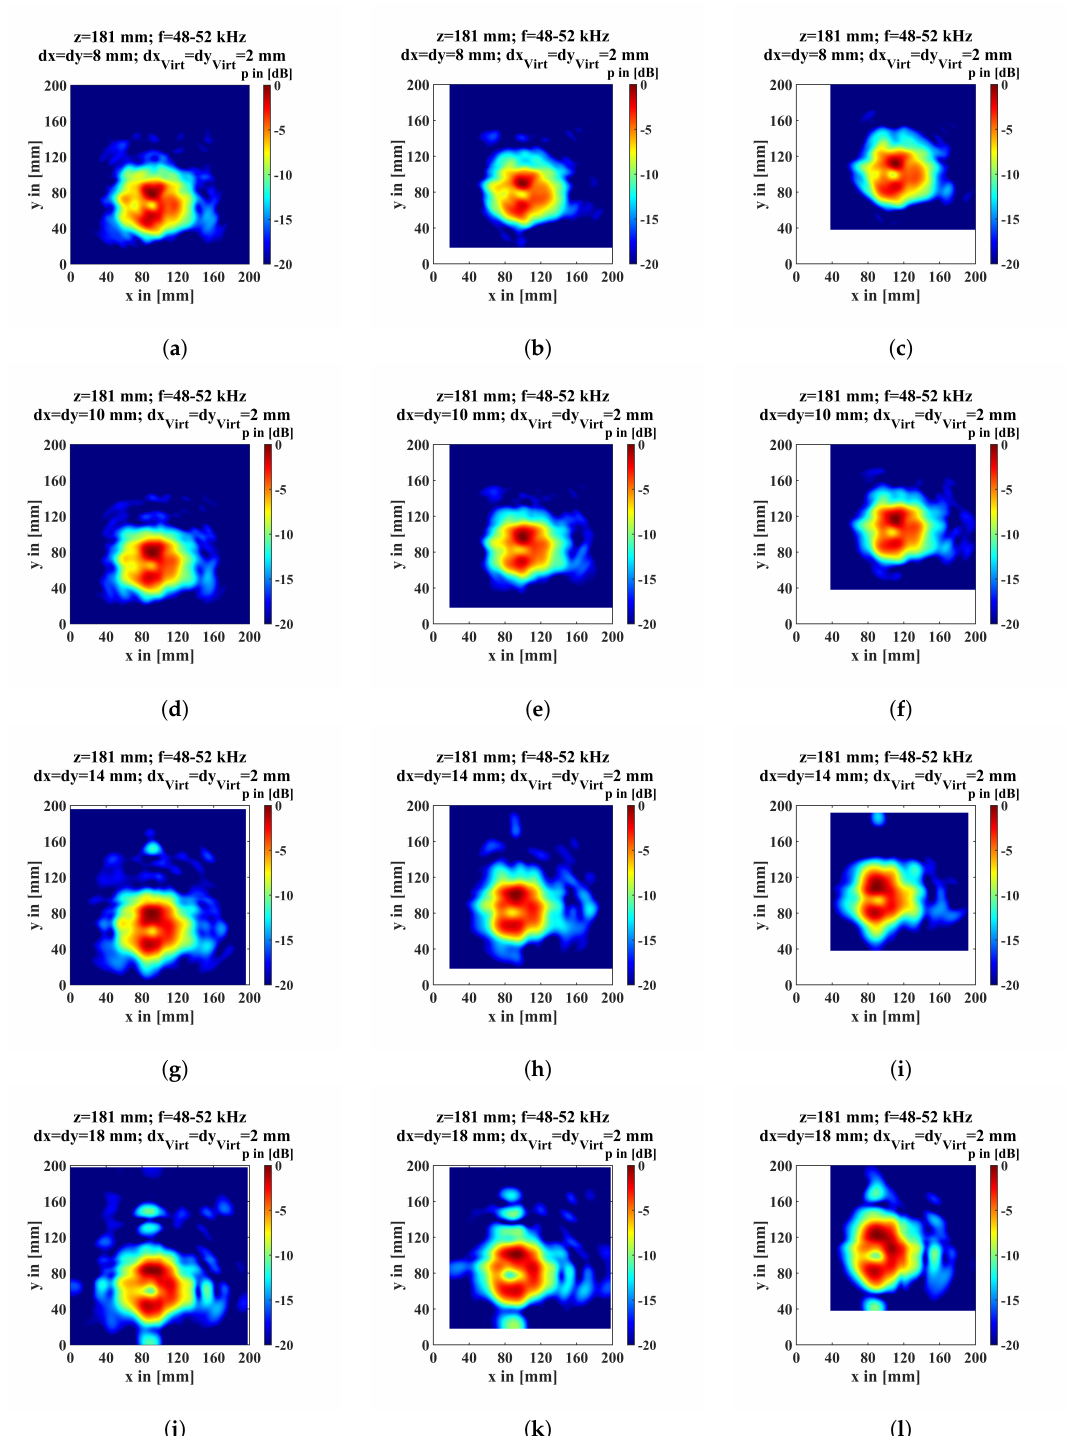
Figure 16. Results of the coarsest identified measuring grid of the different flaws with different measuring grid position. ( a – c ) The 4 mm flaw with 8 mm grid point distance, ( d – f ) the 5 mm flaw with 10 mm grid point distance, ( g – i ) the 10 mm flaw with 14 mm grid point distance, and ( j – l ) the 20 mm flaw with 18 mm grid point distance. In the first column, with the default measuring grid position. In the second column, with a 20 mm shifted measuring grid and in the third column with a 40 mm shifted measuring